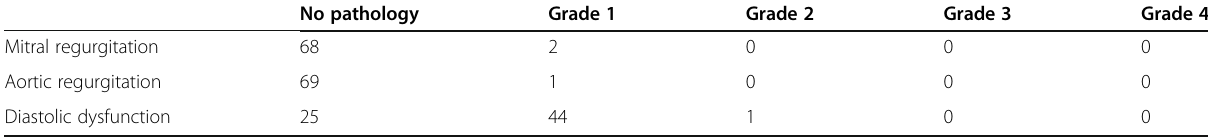
Table 3 Number of disease-free individuals and patients with diastolic dysfunction, mitral, and aortic regurgitation